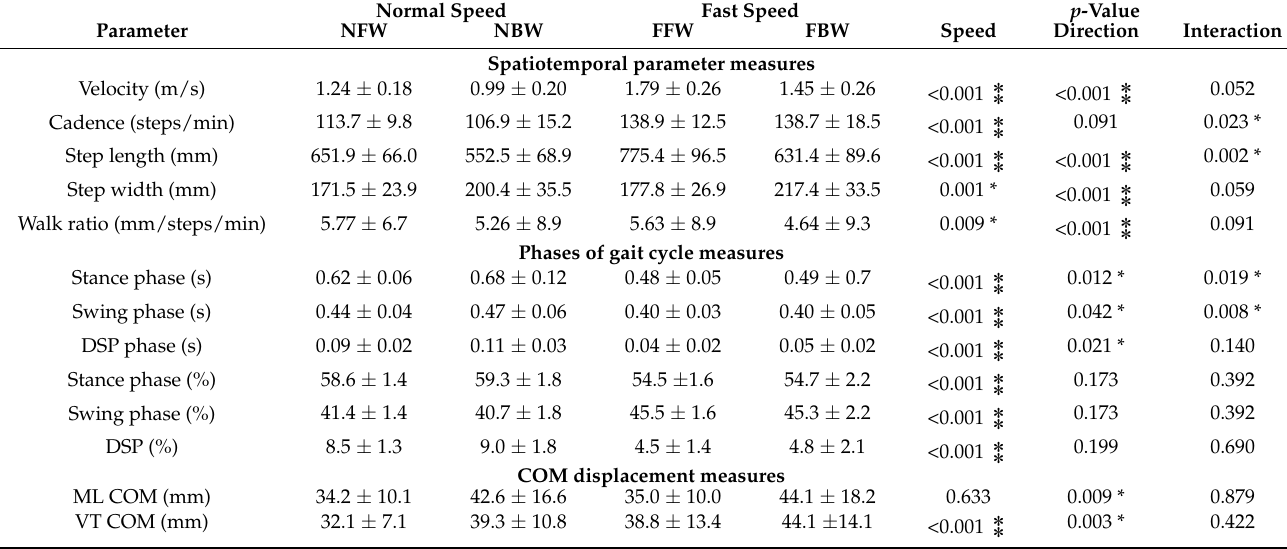
Table 2. Effects of walking direction and speed.